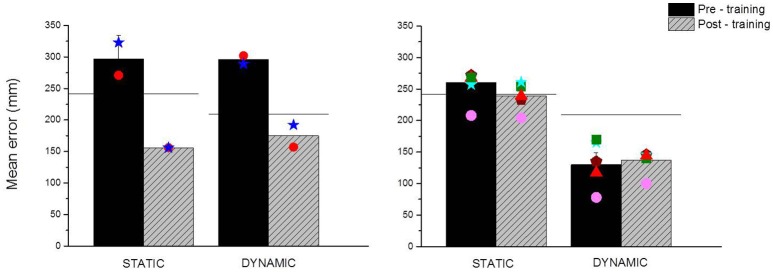
Main outcomes of the rehabilitation training performed with ABBI. The panels show the mean localization error in millimeters obtained by early blind (Left) and low vision children (Right) in the pre-training (black bars) and post-training (gray bars) sessions of the dynamic and the static tasks. Mean localization error is calculated as the distance between the correct and the perceived position of the sound source. Horizontal black lines represent the spatial performance of age-matched sighted children in the static and dynamic conditions of the localization task. Colored symbols represent the individual data of visually impaired children.